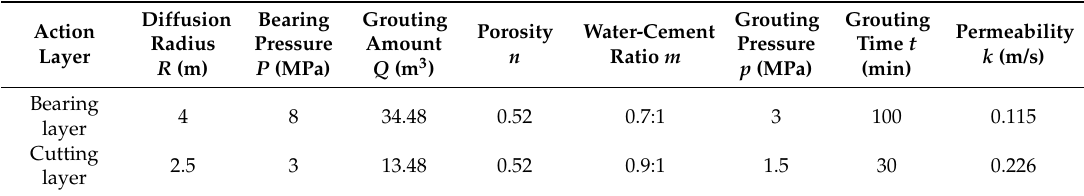
Table 6. Single hole grouting parameters of the caving zone.